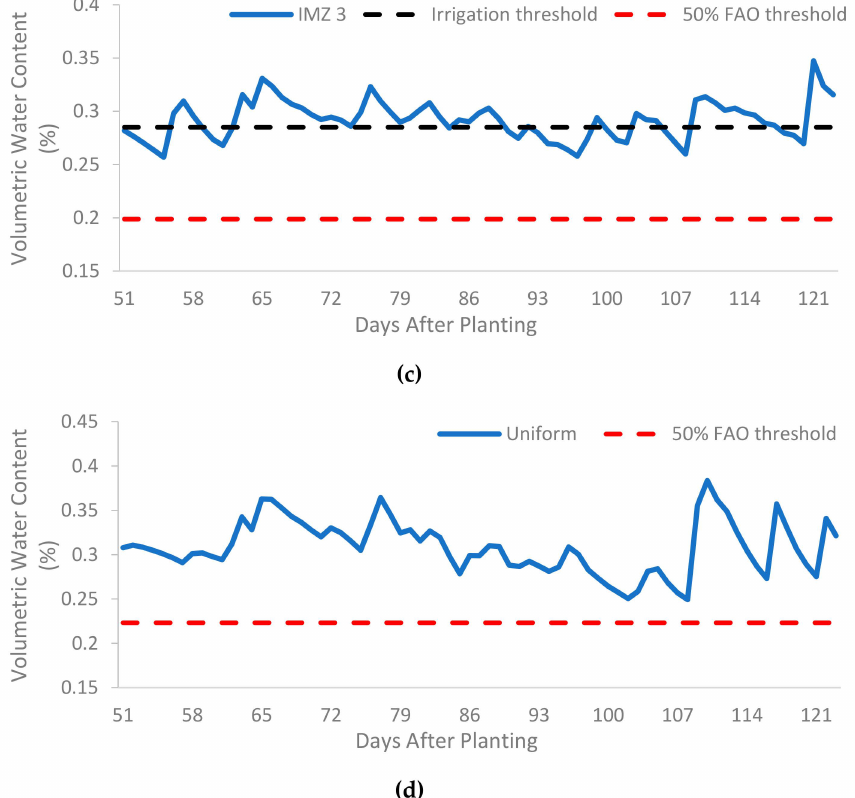
Figure 6. Volumetric water content (VWC) data for the three IMZs ( a–c ) and the uniform area ( d ). Horizontal black dotted lines represent the irrigation threshold used for scheduling irrigation over the 2015 growing season (only for the three IMZs), red dotted lines represent the 50% total available soil water in the root zone (TAW) threshold calculated using the FAO method